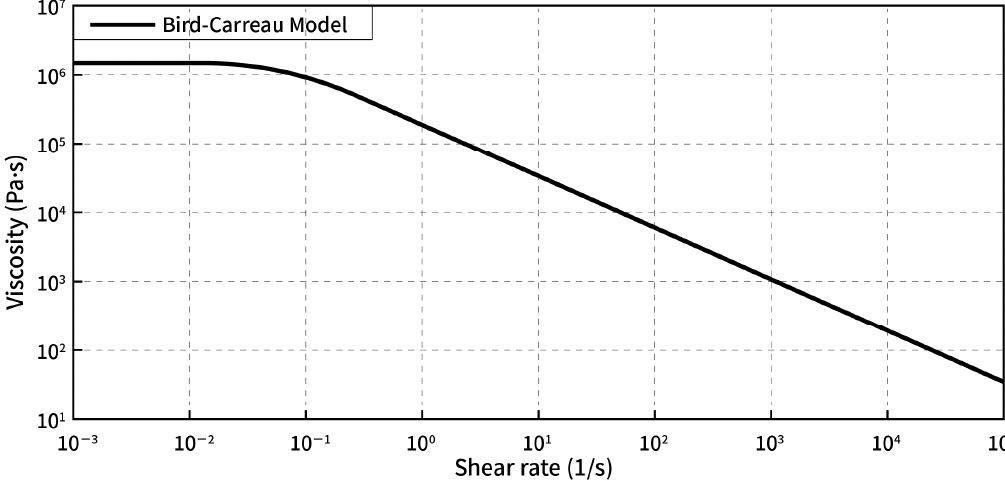
Figure 2. Rheological model of rubber.